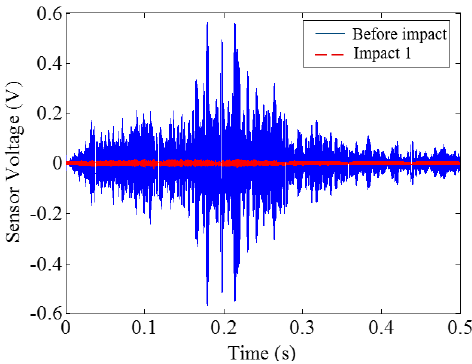
Figure 23. Time-domain signal received by SA sensor in Mortar-2.